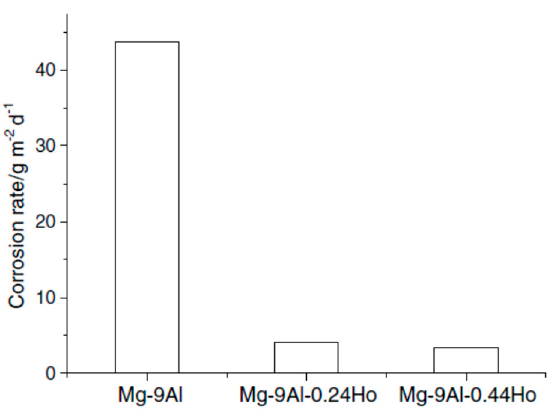
Figure 32. Corrosion rate of AZ91D with and without Ho. Reproduced with permission from [161], Elsevier, 2006.